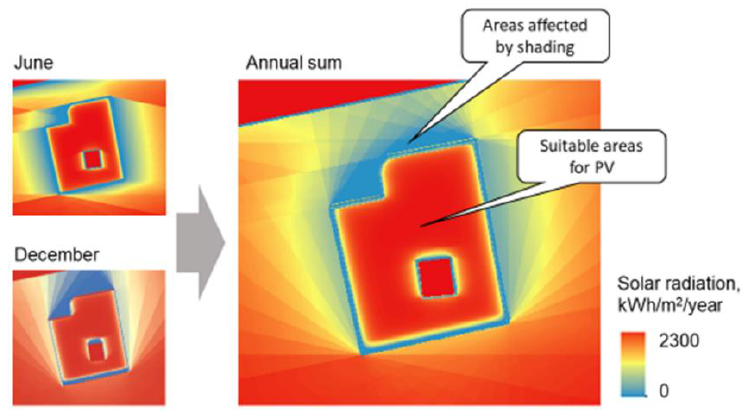
Figure 19. Solar radiation for the Villa 1 during summer and winter.